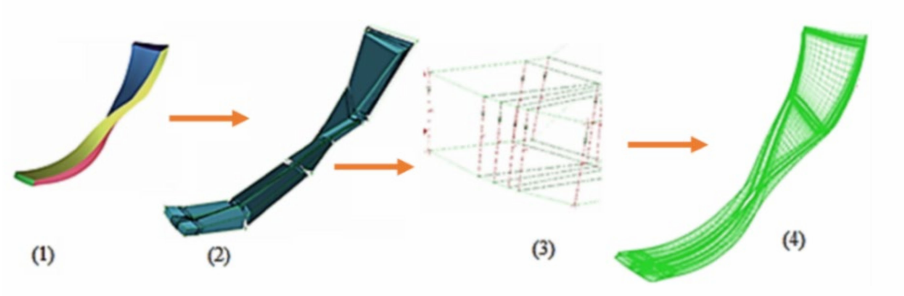
Figure 3. Topological isomorphism for the pre-mesh and domain discretization, where (1 ) analysis domain; ( 2 ) blocking structure; ( 3 ) edge parameters for the blocking structure; ( 4 ) discretization grid.